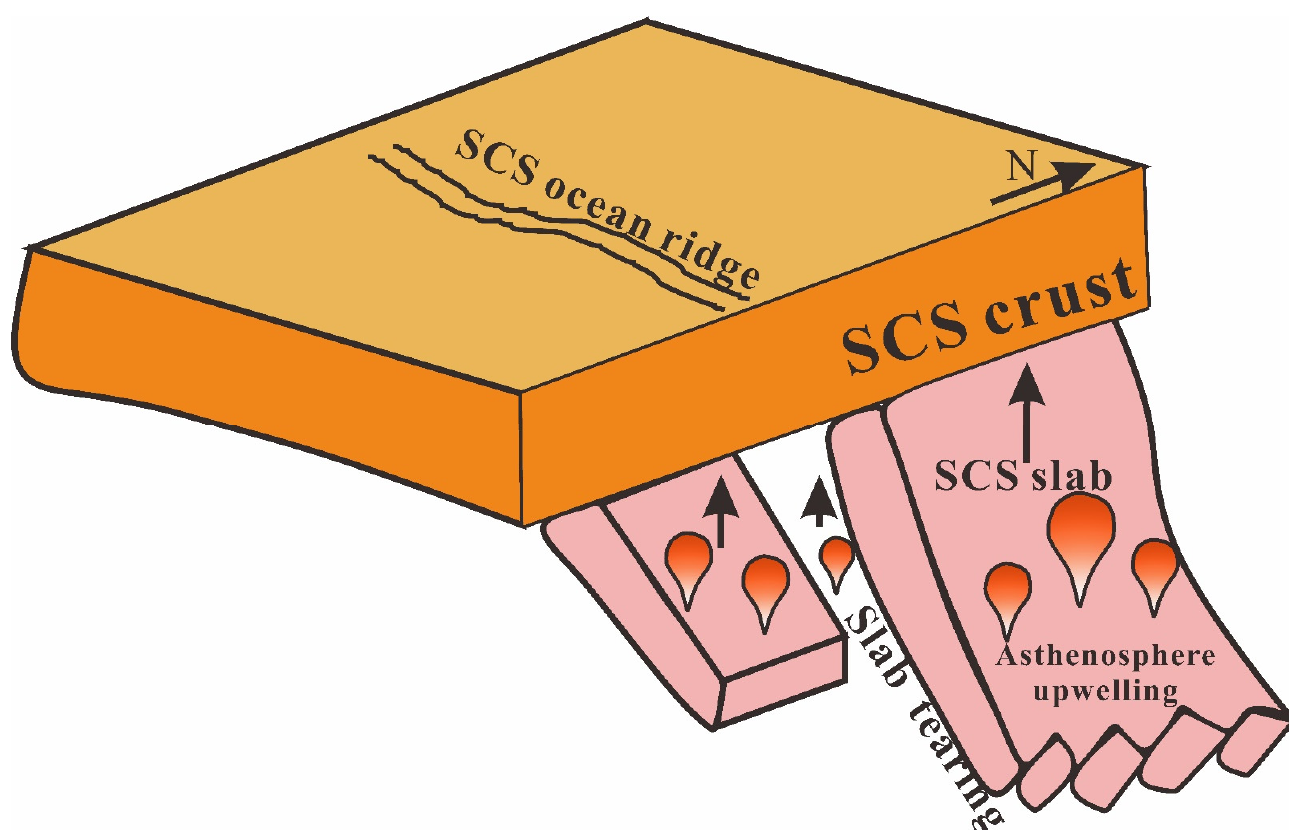
Figure 10. Interpretation cartoon presenting the slab tearing of the South China Sea in the Philippine subduction zone.